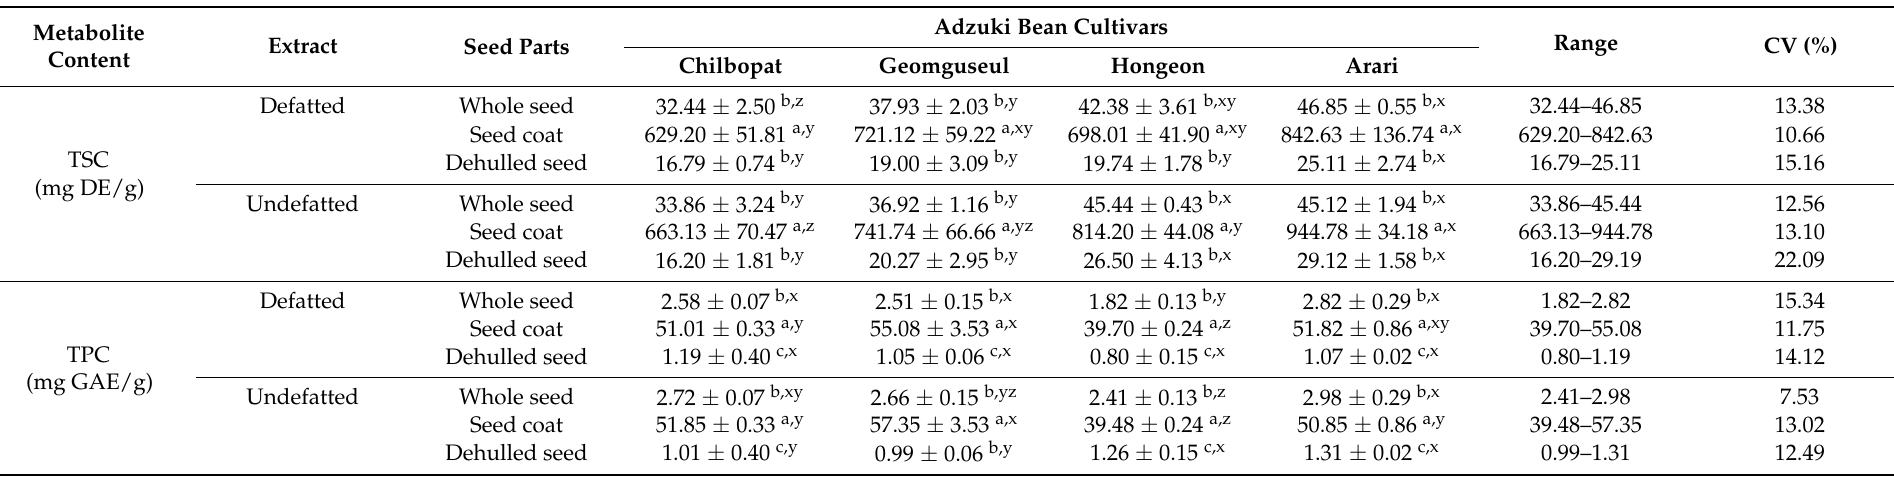
Table 2. Total saponin and total phenolic contents in the whole seeds, seed coats, and dehulled seeds of four Korean adzuki bean